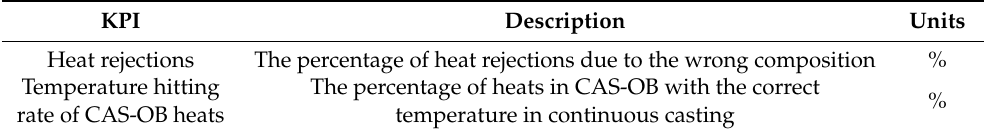
Table 8. Key performance indicators for the RL agent application to the CAS-OB